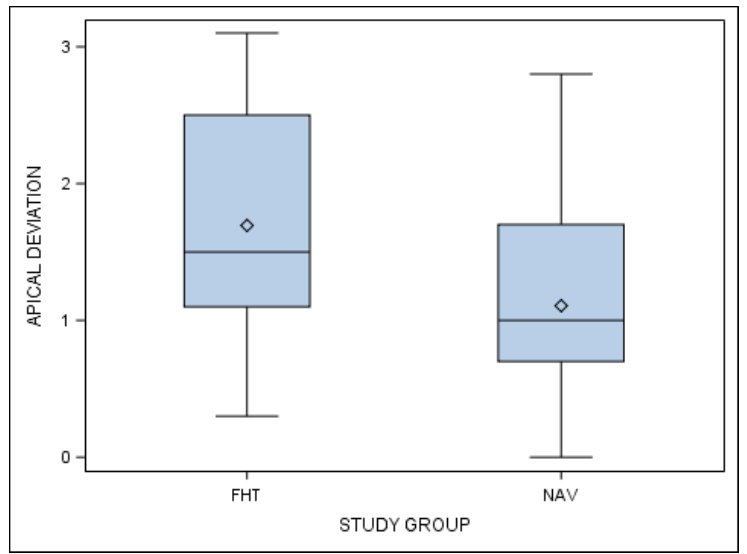
Figure 6. Box plot of the coronal entry-point deviations of the orthodontic micro-screws in the selected tooth positioning. Additionally, statistically significant differences at the apical end-point deviations of planned and performed orthodontic micro-screws between the computer-aided static navigation technique and conventional freehand technique study groups are shown ( p < 0.001) (Figure 7).